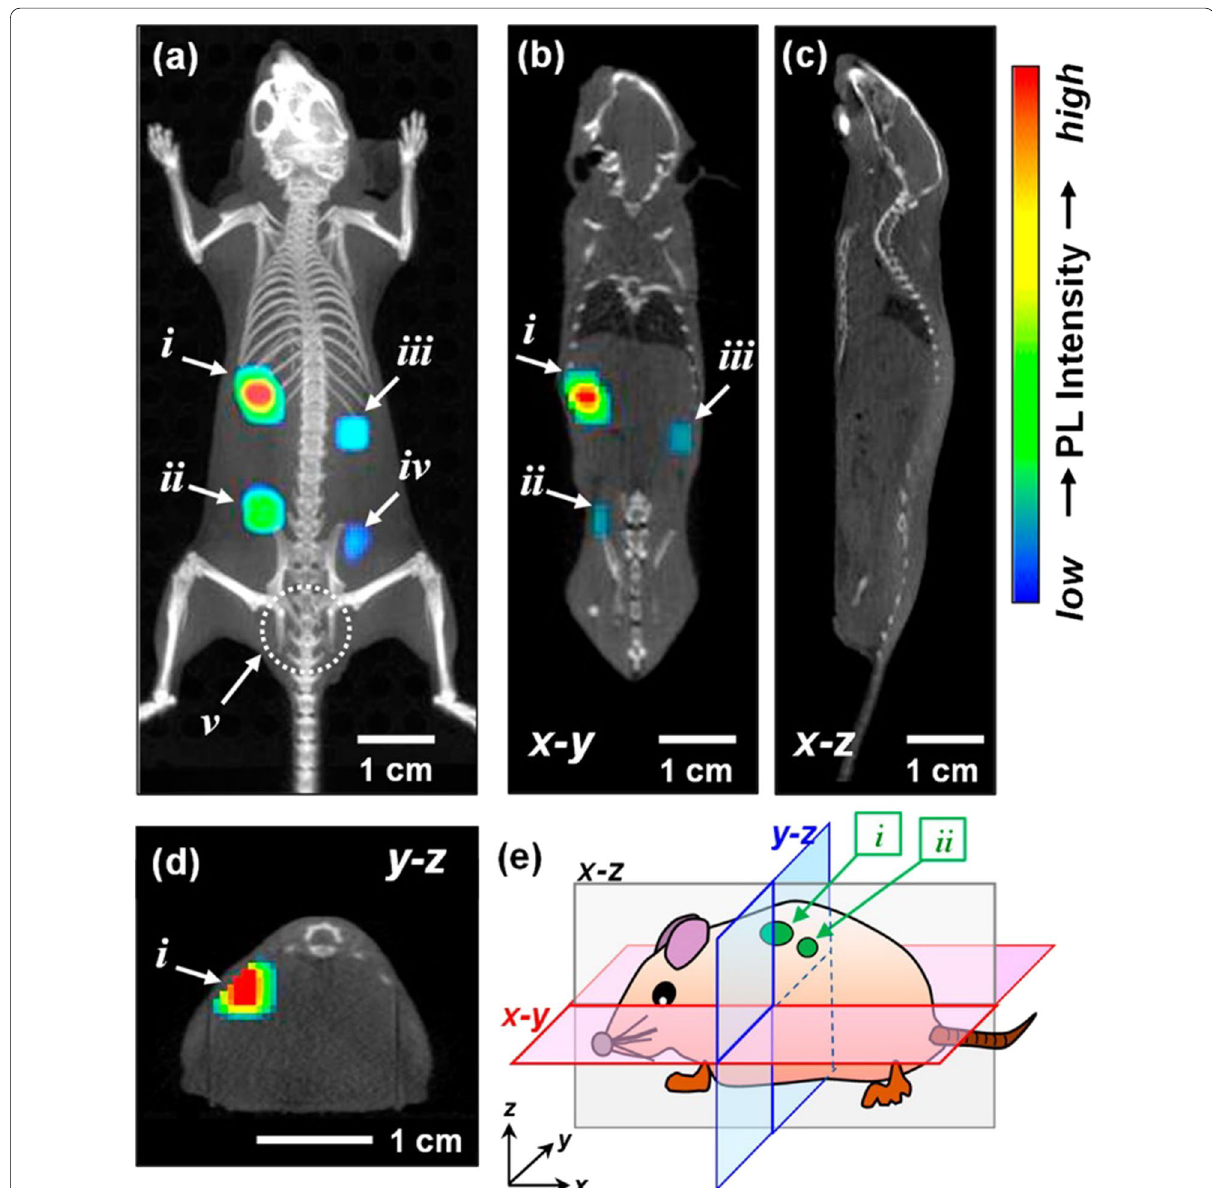
Fig. 2 Three-dimensional PL image superimposed on an X-ray CT image of the mouse subcutaneously injected with DSPC-AIGSe@GaS x liposome dispersions (each 50 mm 3 ) in the back